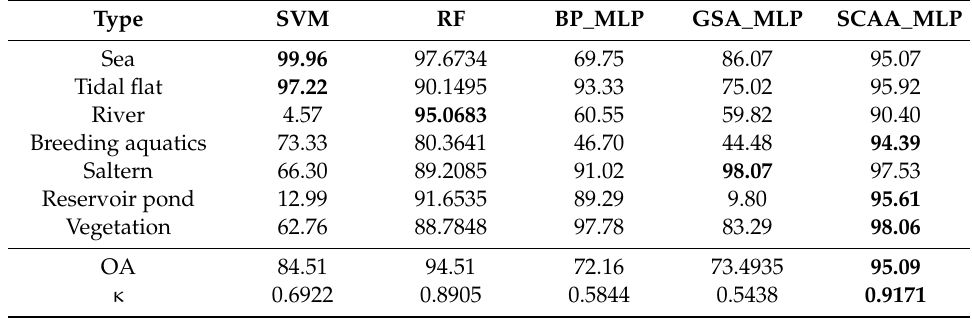
Table 3. The classification accuracy of different classifiers in Jiaozhou Bay wetland. OA—overall accuracy.